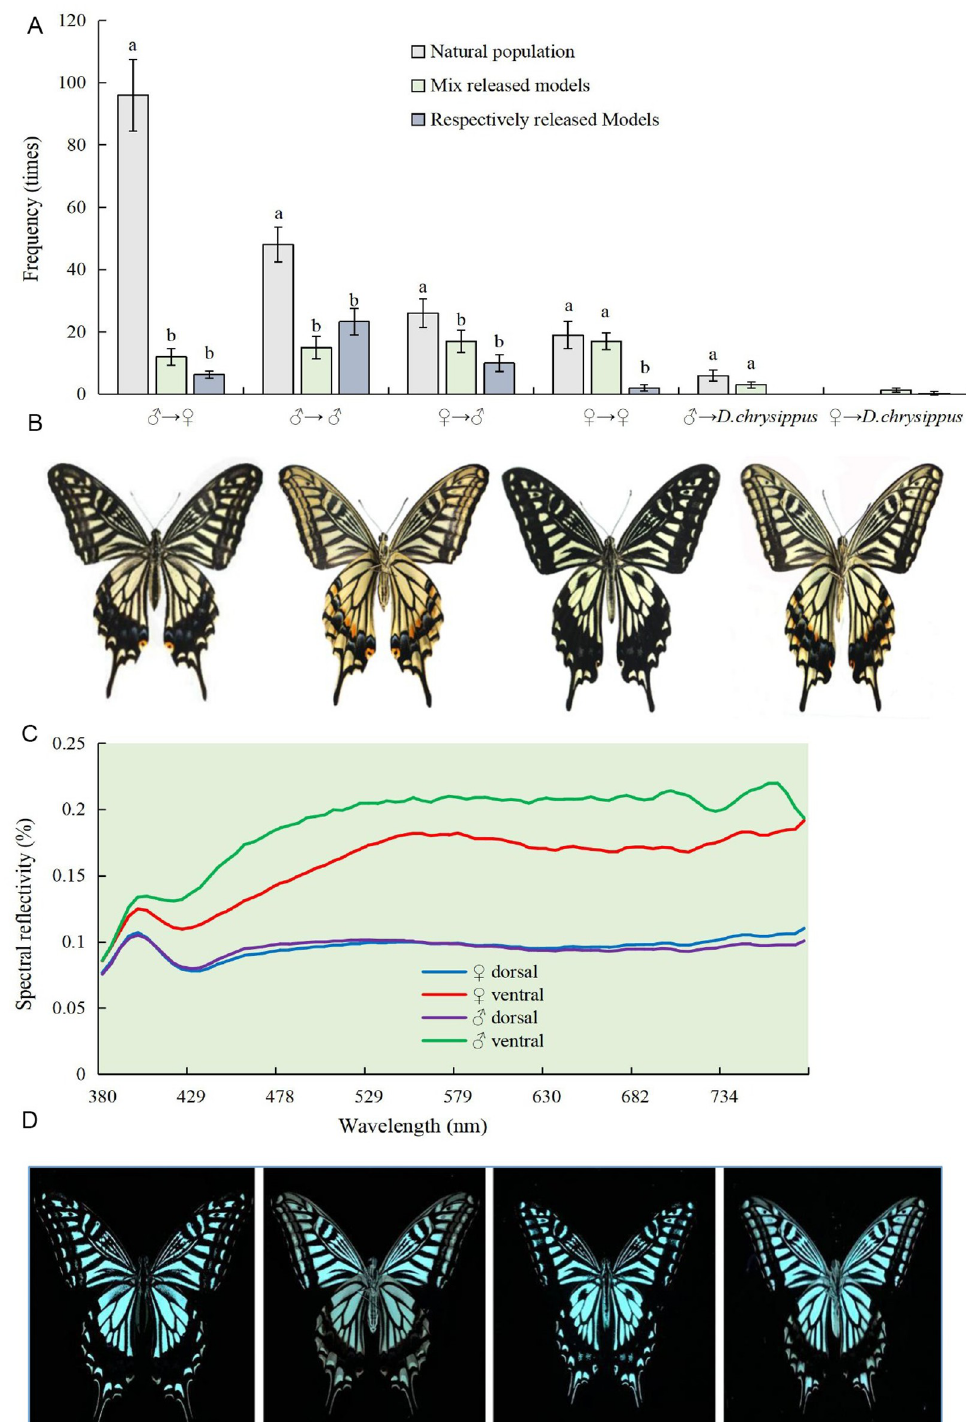
Fig 4. Chase behavior of P . xuthus during courtship and wing reflection spectrum. A. Chase behavior of P . xuthus during courtship using both natural butterflies and butterfly models. B. Representative butterfly specimen under natural light. C. Reflective spectrum of the butterfly specimen. D. Images of butterfly specimen under UV light. Notes: Histograms with alphabet above bars indicates significant difference under the same chasing behavior at P < 0.05 (N = 9; LSD method).